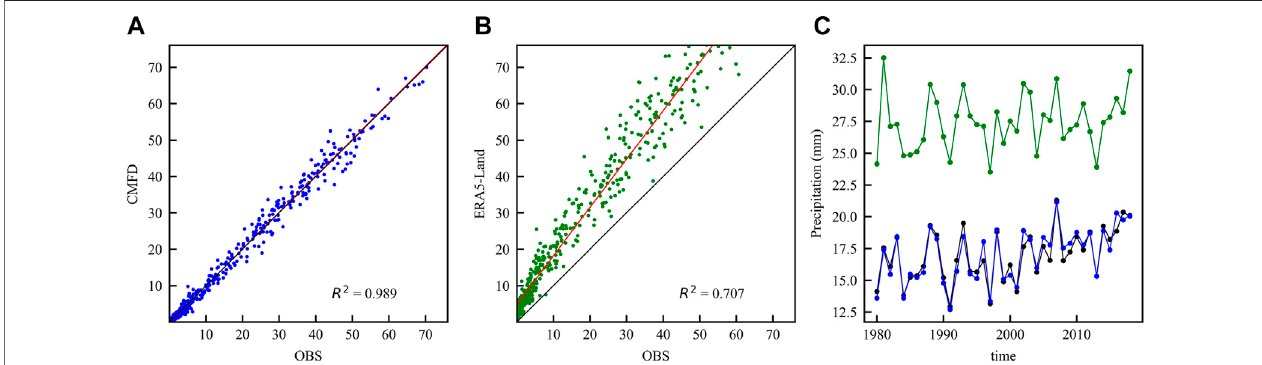
FIGURE 3| Scatter plots of the site observations versusmonthlyprecipitation estimates derived from (A) CMFD and (B) ERA5-Land.The black solid lineis the 1:1 line,andtheredsolidonerepresentsthelinearregression fi ttingline. (C) TimeseriesofmeanmonthlyprecipitationintheQilianMountainsfortheperiod1980 – 2018,from observations (OBS, thin black line), CMFD (thin blue line), and ERA5-Land (thin green